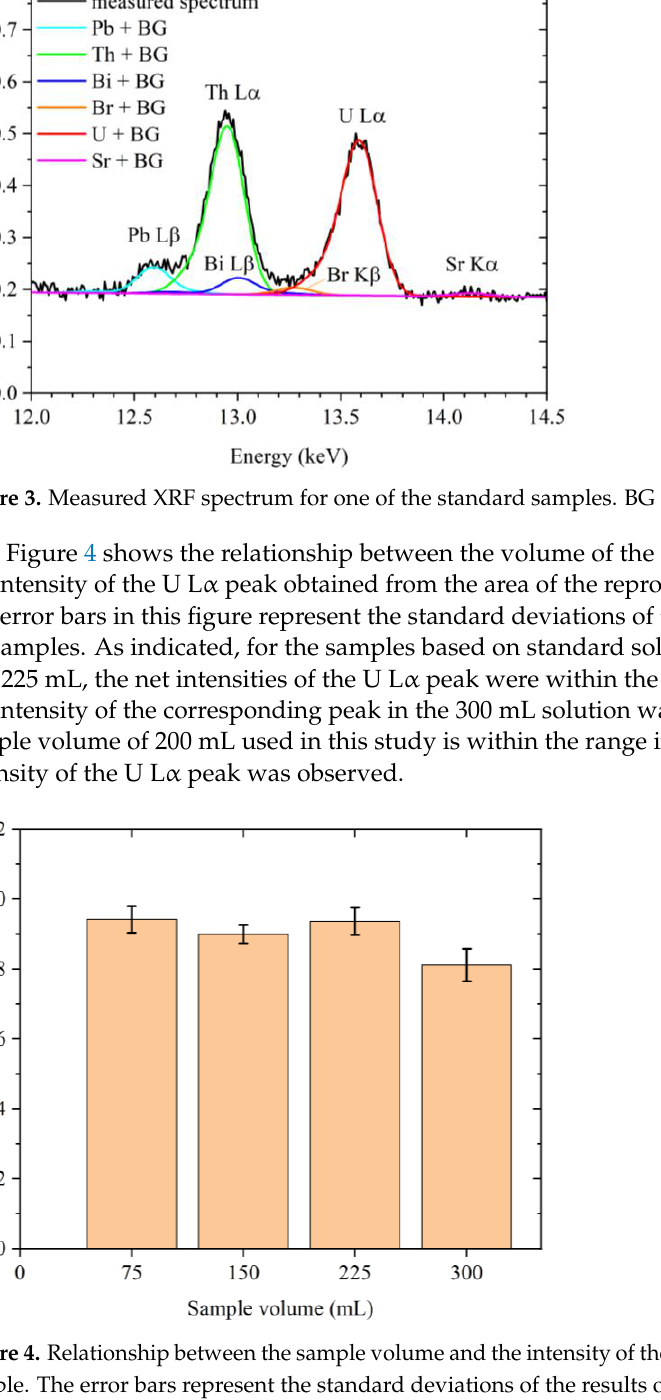
Figure 3. Measured XRF spectrum for one of the standard samples. BG = background intensity.